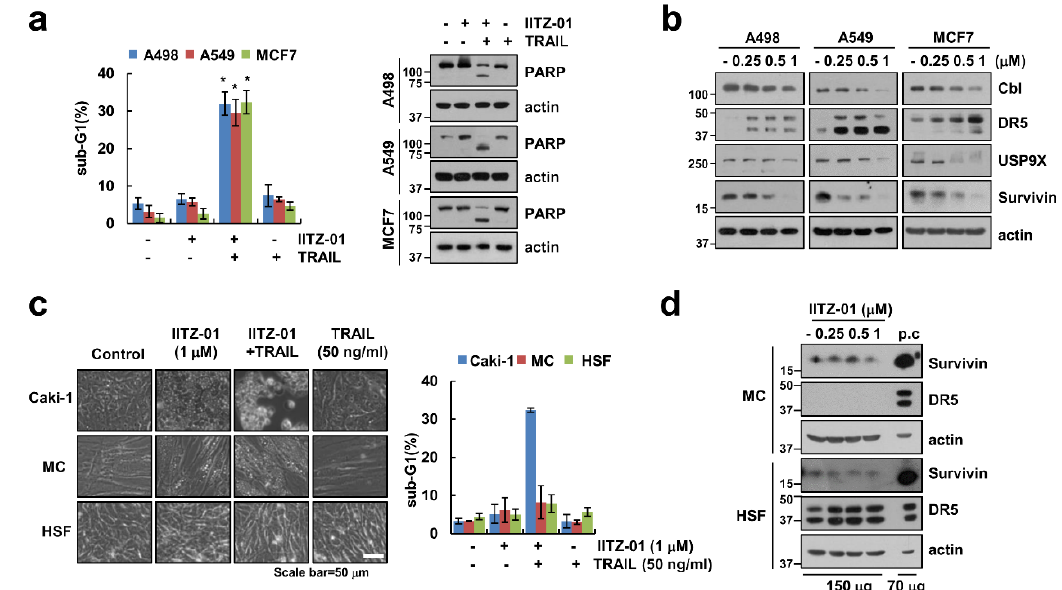
Figure 7. IITZ-01 plus TRAIL induces apoptosis on other carcinoma cells, but not normal cells. ( a ) Renal carcinoma (A498), lung carcinoma (A549) and breast carcinoma (MCF7) were incubated with 1 μM IITZ-01 and/or 50 ng/mL TRAIL for 18 h; ( b ) A498, A549 and MCF7 cells were incubated with 0.25–1 μM IITZ-01 for 18 h; ( c ) Caki-1, human renal normal mesangial cells (MC) and human skin fibroblast (HSF) cells were incubated with 1 μM IITZ-01 and/or 50 ng/mL TRAIL for 18 h. The cell morphology was examined using interference light microscopy; ( d ) MC and HSF cells were incubated with 0.25–1 μM IITZ-01 for 18 h. (positive control (p.c); Caki-1 cell lysate). The apoptotic population (sub-G1) and protein levels were analyzed by flow cytometry ( a , c ) and Western blotting ( a , b , d ), respectively. The values in graph ( a , c ) represent the mean ± SD of three independent experiments. * p < 0.05 compared to the control.